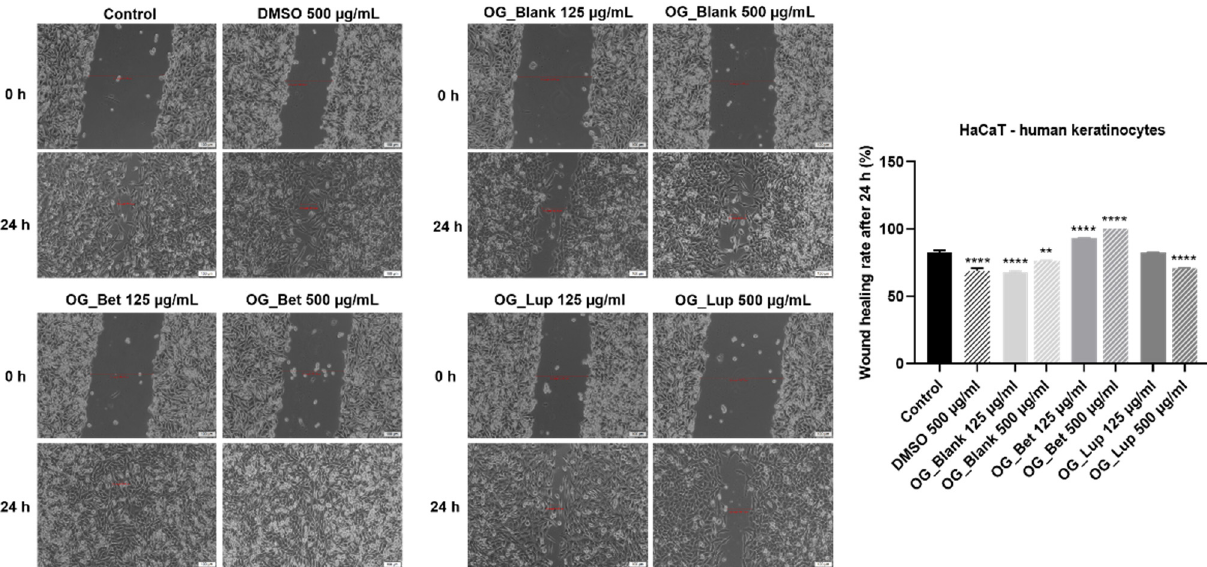
Figure 6. The influence of Blank OG, Bet OG, and Lup OG (125 and 500 µg/mL) on the migratory ability of human immortalized keratinocytes (HaCaT) by applying the wound-healing assay. The bar graphs are presented as wound closure percentage after 24 h of treatment in comparison to the initial surface at 0 h. The results are expressed as mean values ± SD of three experiments performed in triplicate. The statistical differences between treated and non-treated (Control) cells were identified by performing the one-way ANOVA analysis and the Dunnett’s multiple comparisons post-test (** p < 0.01; **** p < 0.0001). The scale bars represent 100 µm.